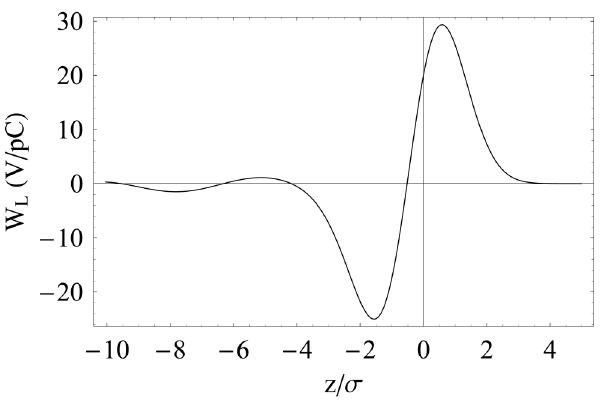
FIG. 2. Phase plot for the Hamiltonian H (cid:5) (cid:2); (cid:7) (cid:6) (cid:1) (cid:1)